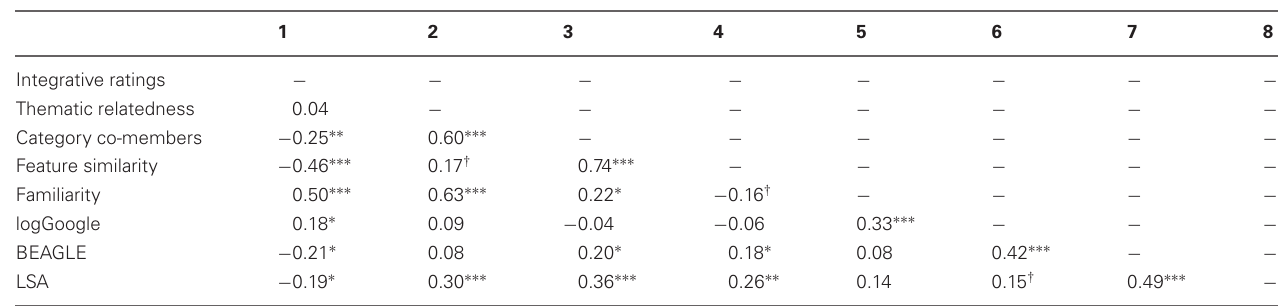
Table 5 | Study 3, Inter-correlations of ratings and computation